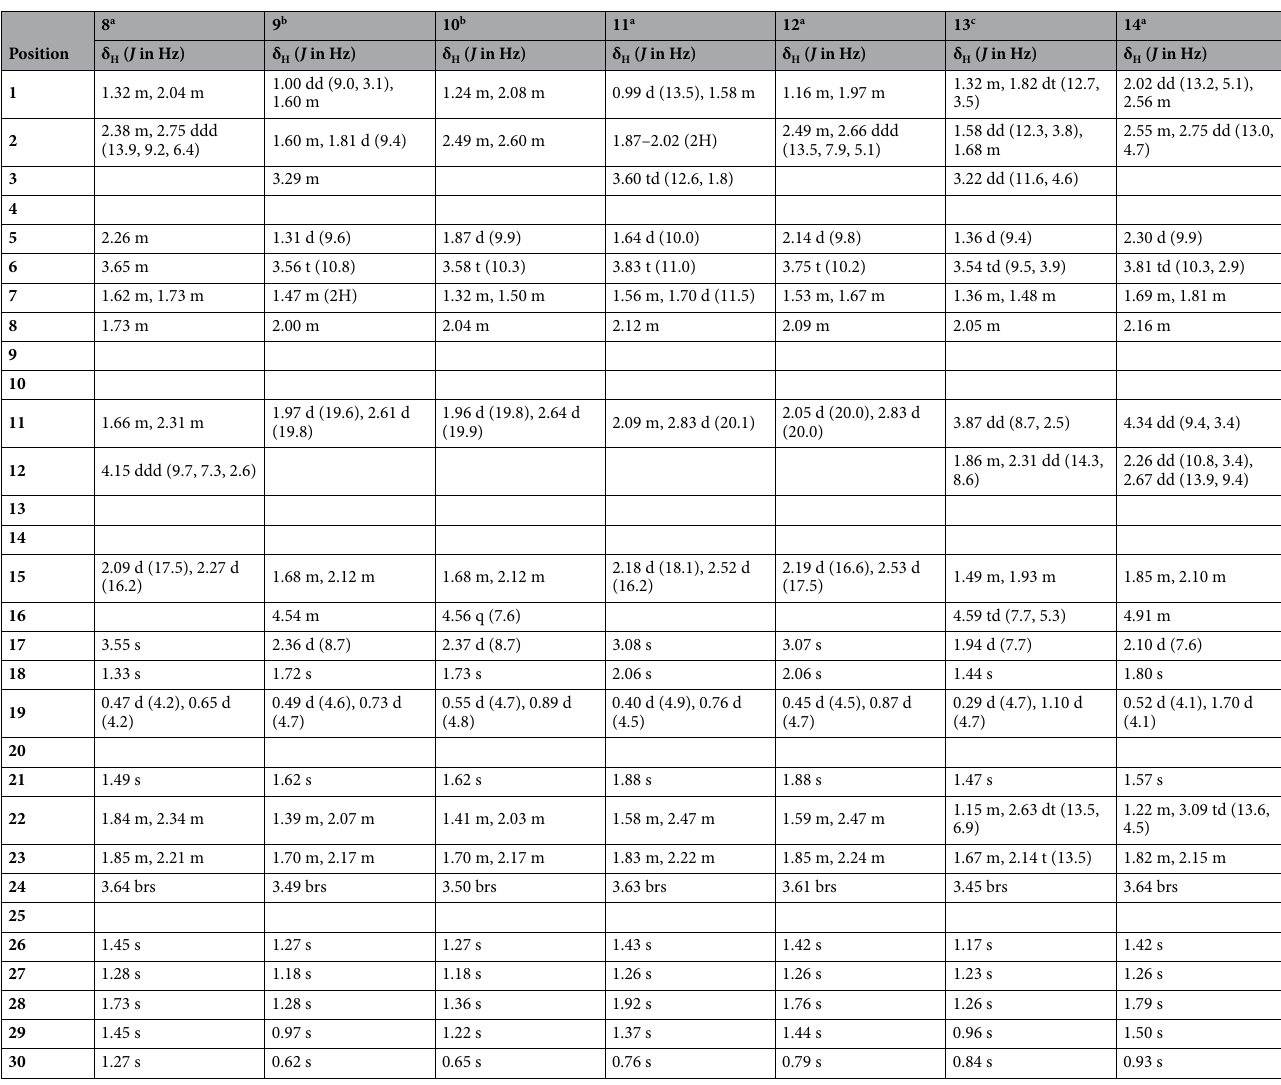
Table 3. 1 H NMR spectroscopic data of compounds 8 – 14 (400 MHz). a In C 5 D 5 N. b In CDCl 3 . c In CD 3 OD and a drop of C 5 D 5